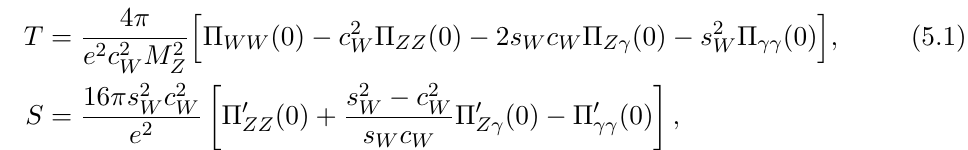
m S = 200 GeV. The gray area is excluded by Z width (cid:0) (cid:6) (cid:31) 0 (cid:31) 0 is open for 1 1 !